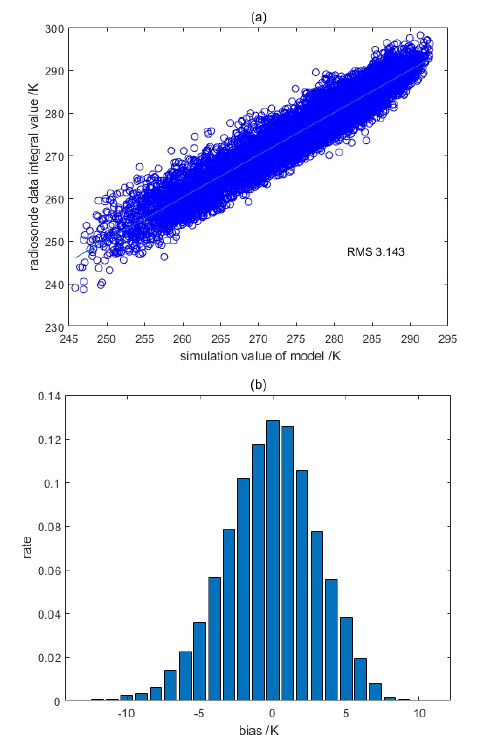
Figure 5. Relationship between model simulation value